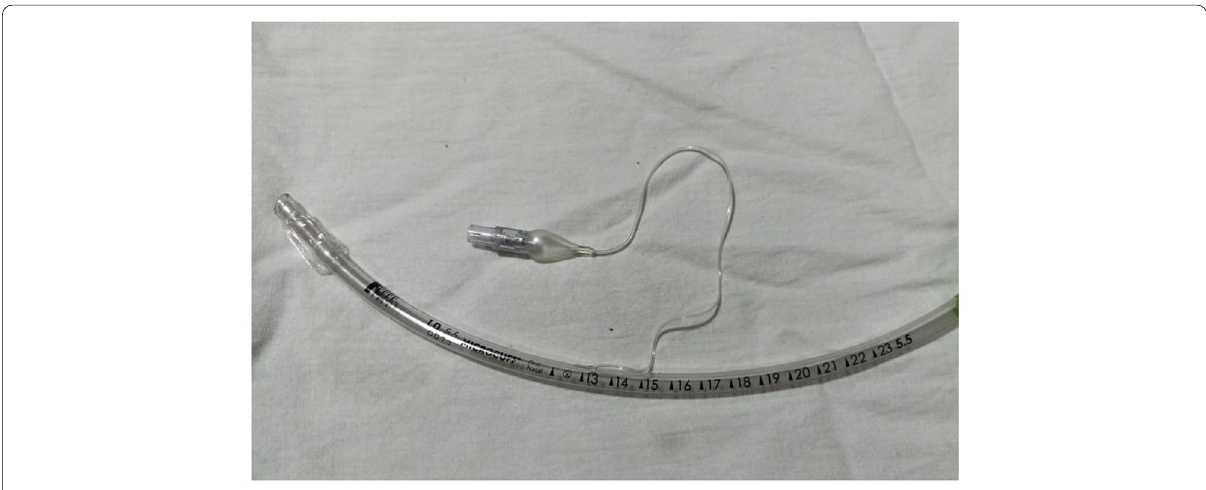
Fig. 4 5.5 mm microcuffed endotracheal